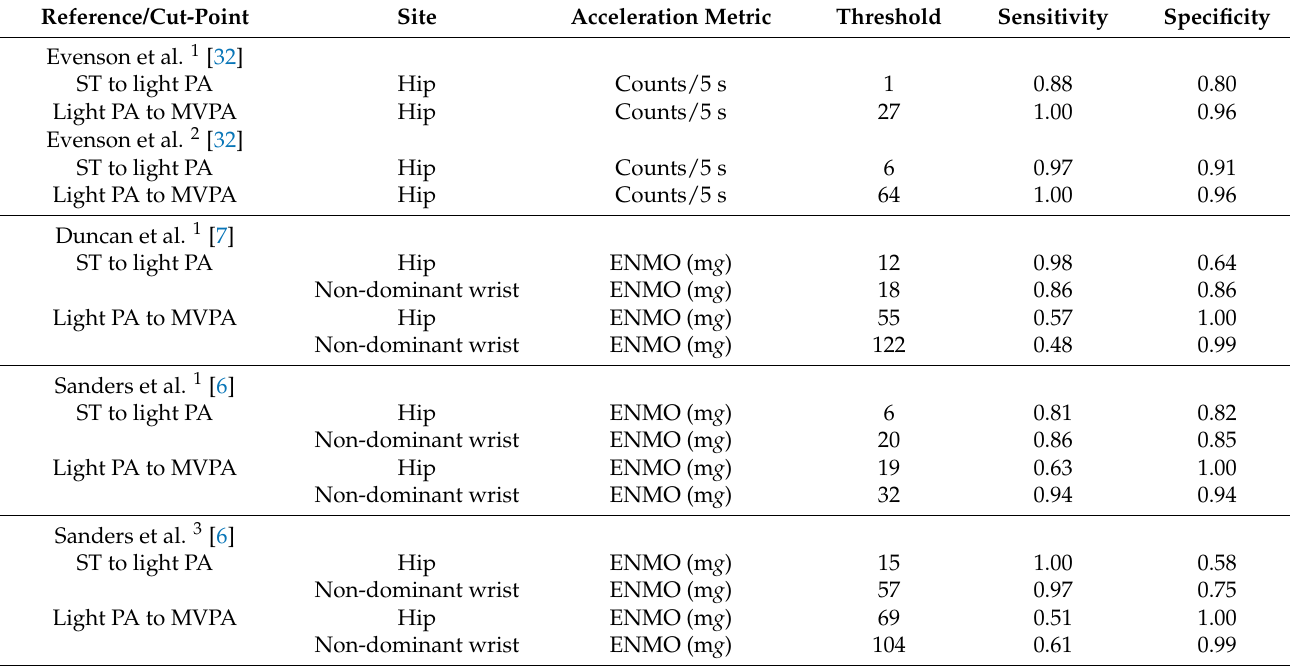
Table A2. Cross-validation of the previously derived thresholds to classify ST, light, and MVPA intensities in the cross- validation sample